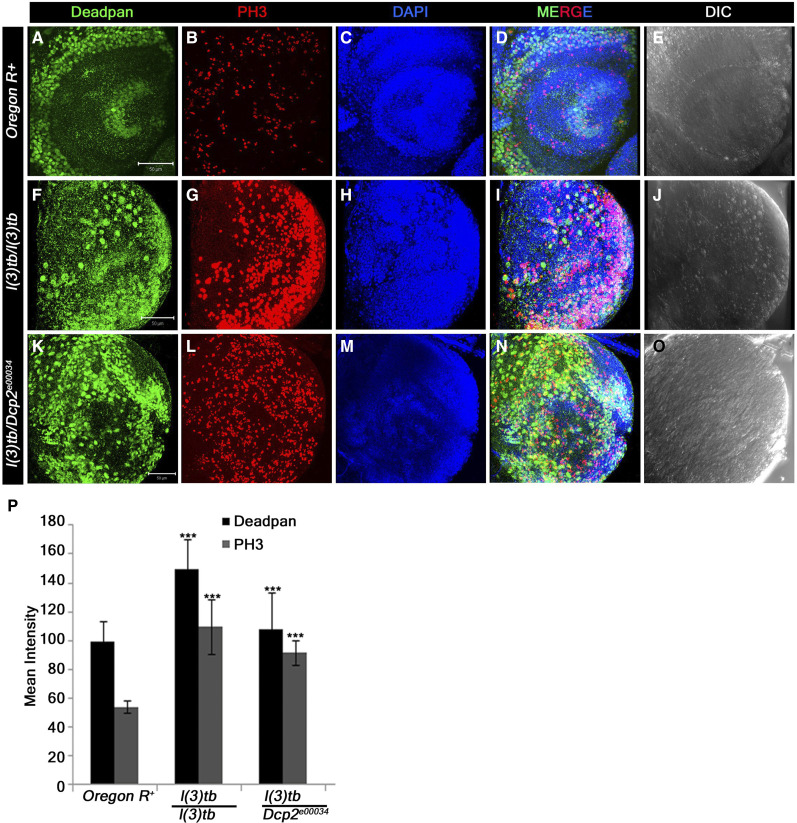
Trans-heterozygotes of DCP2 mutants and l(3)tb show tumorous larval brain with elevated neuroblast numbers. Heterozygous combination of l(3)tb with DCP2e00034 allele resulted in significant increase in the number of neuroblasts and mitotically active cells. Confocal projections showing immunolocalisation of Deadpan, a neuroblast marker (Green, A, F, K) and PH3 (red, B, G, L) marking the mitotic cells, show enhanced neuroblast population in homozygous mutant (F) and in heterozygous l(3)tb with DCP2e00034 allele (K). Similarly, increased number of mitotic cells (PH3 positive) are also observed in heterozygous l(3)tb with DCP2e00034 allele (L), similar to homozygous l(3)tb mutant (G). Quantitative analyses of NBs and mitotically active cells show significant differences when compared with the wild type (P). *** P < 0.005. Scale bar indicates 50 µm.